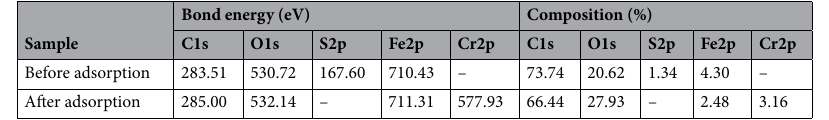
Table 5. The XPS spectral analysis of before and after